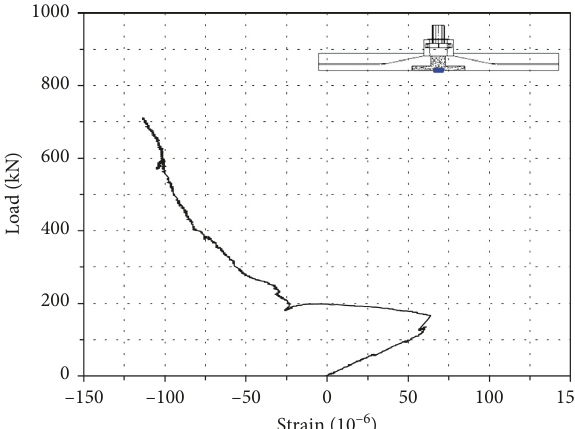
Figure 8: Load-strain relationship of the concrete at center.